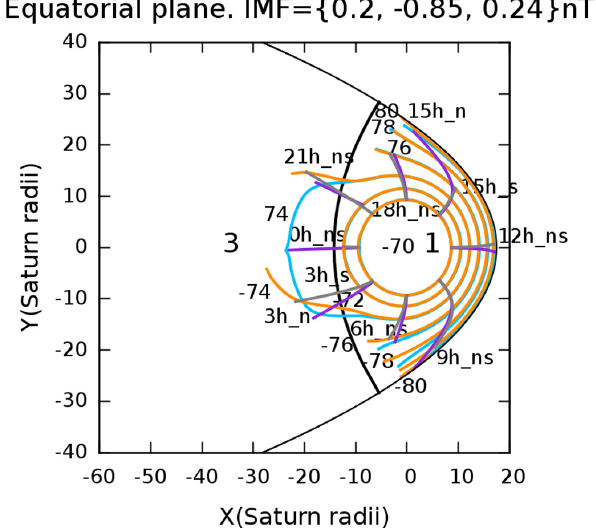
Fig. 3. As in Fig. 1 but for IMF vector (0.20, − 0.85,